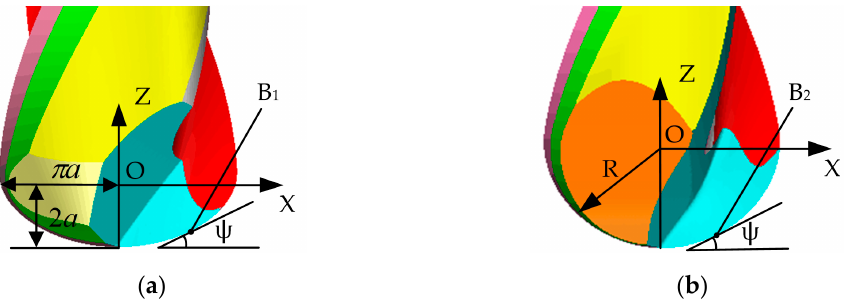
Figure 3. Comparison of equivalent helix angle for ball-end milling cutter and revolving cycloid milling cutter: ( a ) Revolving cycloid milling cutter; ( b ) ball-end milling cutter.